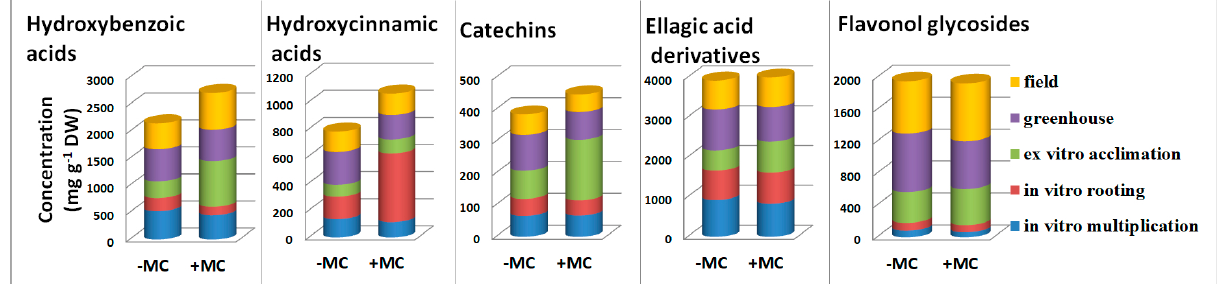
Figure 6. The distribution of phenolic compounds in the aboveground part of strawberry cv. ‘Solnechnaya polyanka’ plants at different propagation stages under the influence of the MC treatment. MC, mechanocomposite.